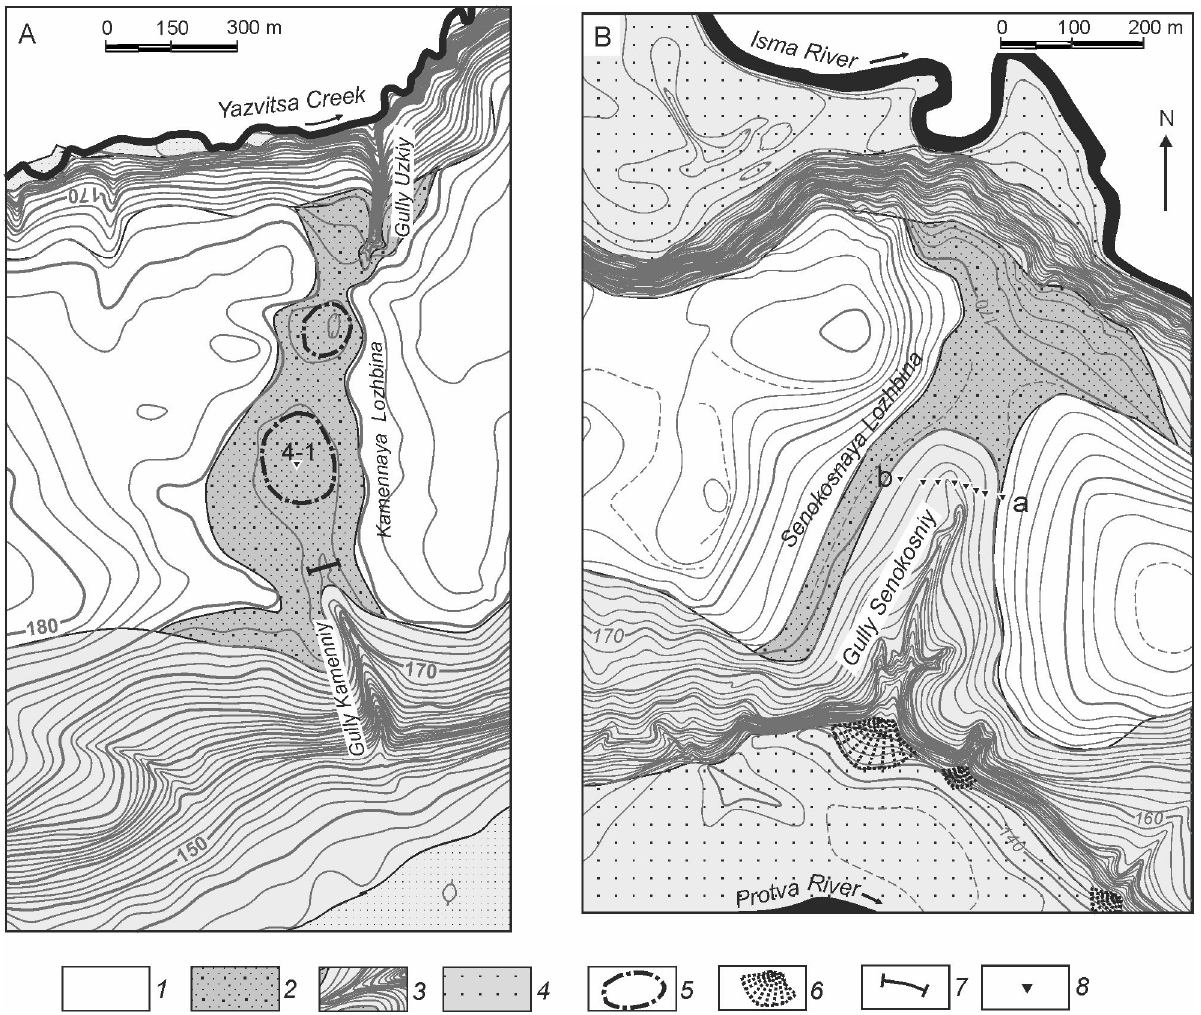
Figure 4. The relief of the SEFs of type 1: Kamennaya ( A ) and Senokosnaya ( B ). Keys: 1—interfluves, 2—meltwater channels, 3—gullies, 4—river floodplain, 5—waterlogged depressions, 6—fans of the gullies, 7—trench, 8—boreholes.